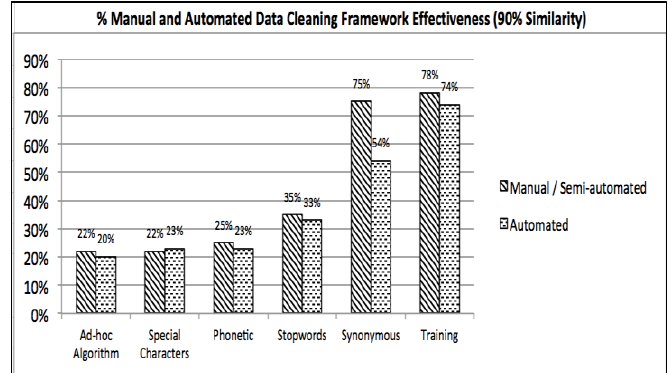
Figure 5: Manual and automated data cleaning environment effectiveness with 90% similarity.